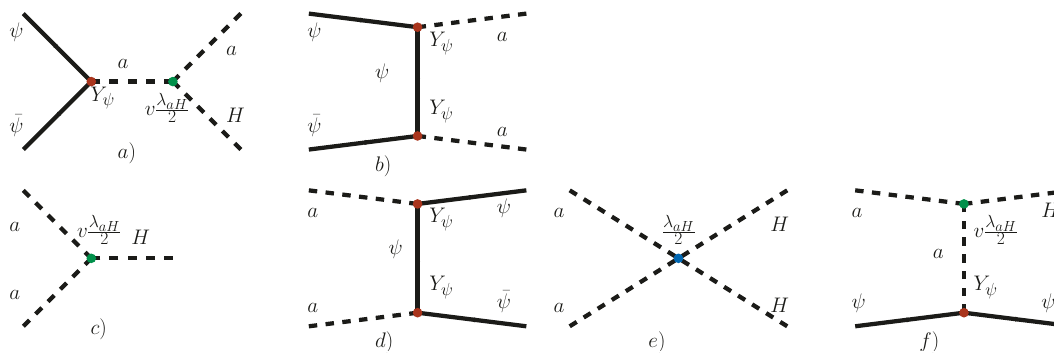
¯ ψ − ψ annihilation;